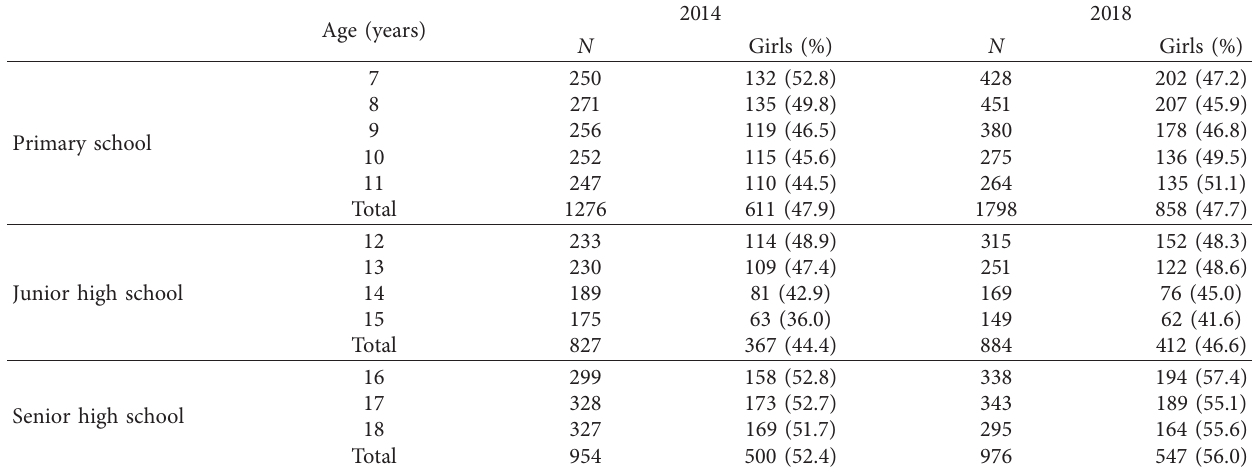
Table 1: Characteristics for each age group in 2014 and